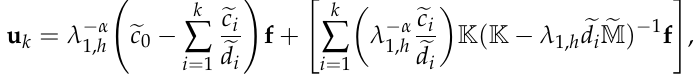
( z ) − z − α , z ∈ [ 1,10 9 ] ( left ) and z ∈ [ 2 × 10 8 ,10 10 ] ( right ), for α = 1 α , k , (cid:96) , k=70, (cid:96) = 0,10,17 ( middle ), and α = 3 2